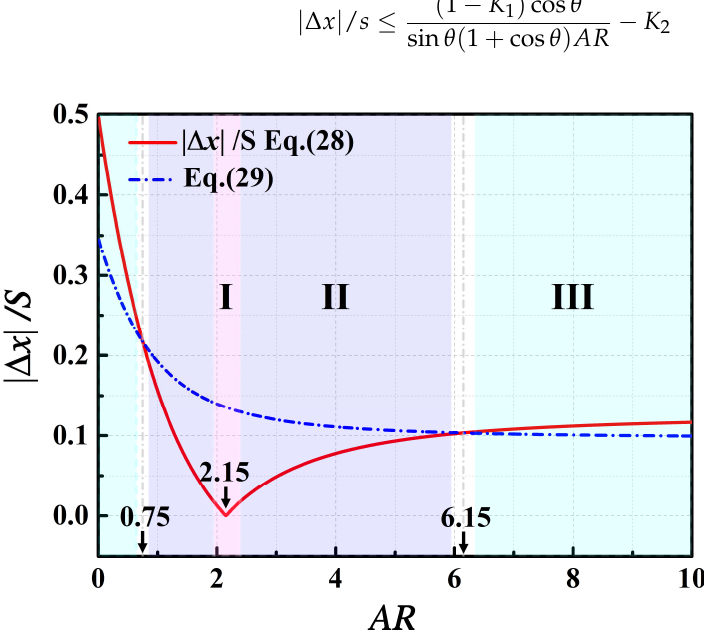
Figure 12. The maximum dimensionless offset distance